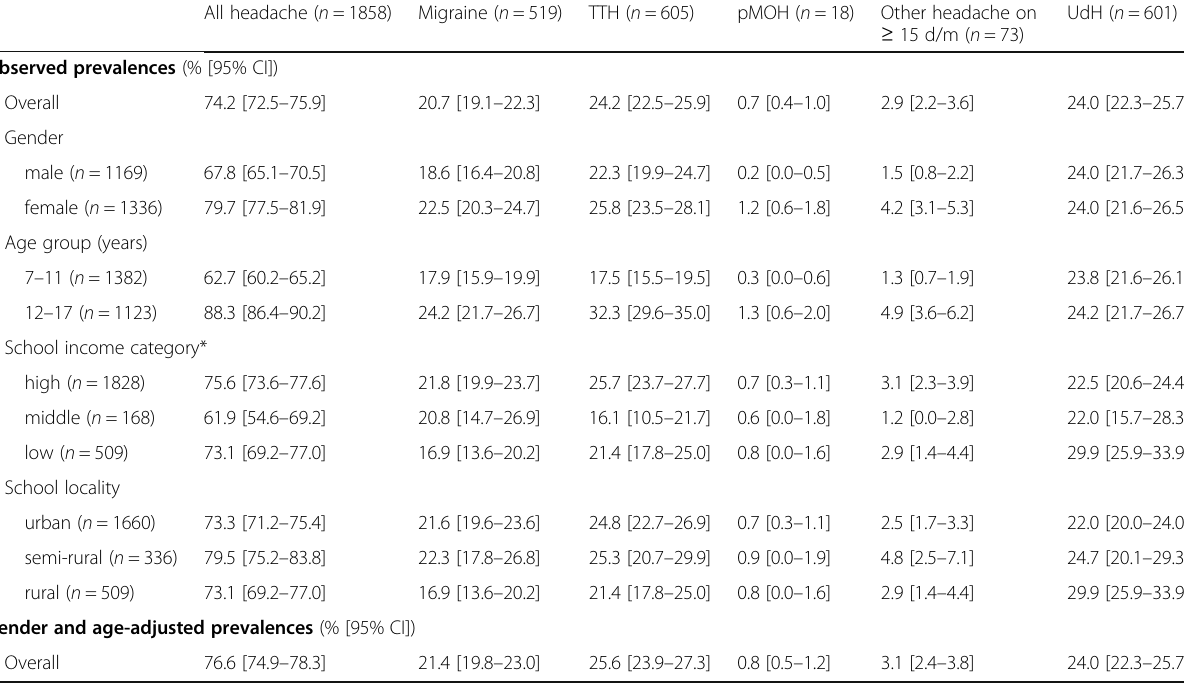
Table 2 Crude (observed) prevalences of all headache and each headache type, overall and according to demographic variables, and gender- and age-adjusted prevalences ( N =